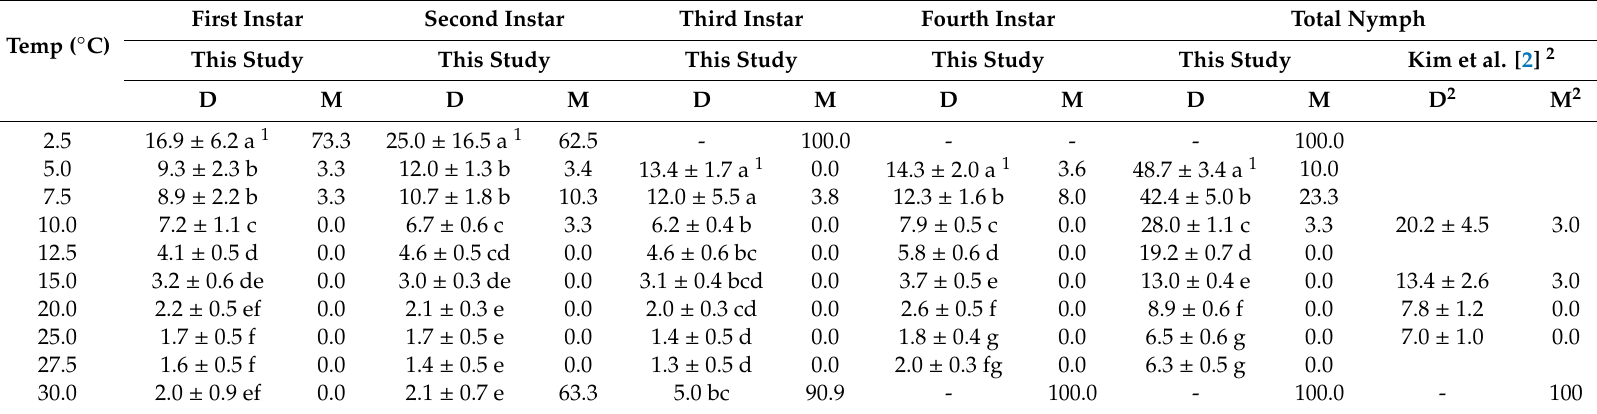
Table 1. Development duration (days, D) (mean ± SD) and stage-specific mortality (%, M) of Aulacorthum solani nymphs on soybean at constant temperatures. First Instar Second Instar Third Instar Fourth Instar Total Nymph Temp ( ◦ C) This Study This Study This Study This Study This